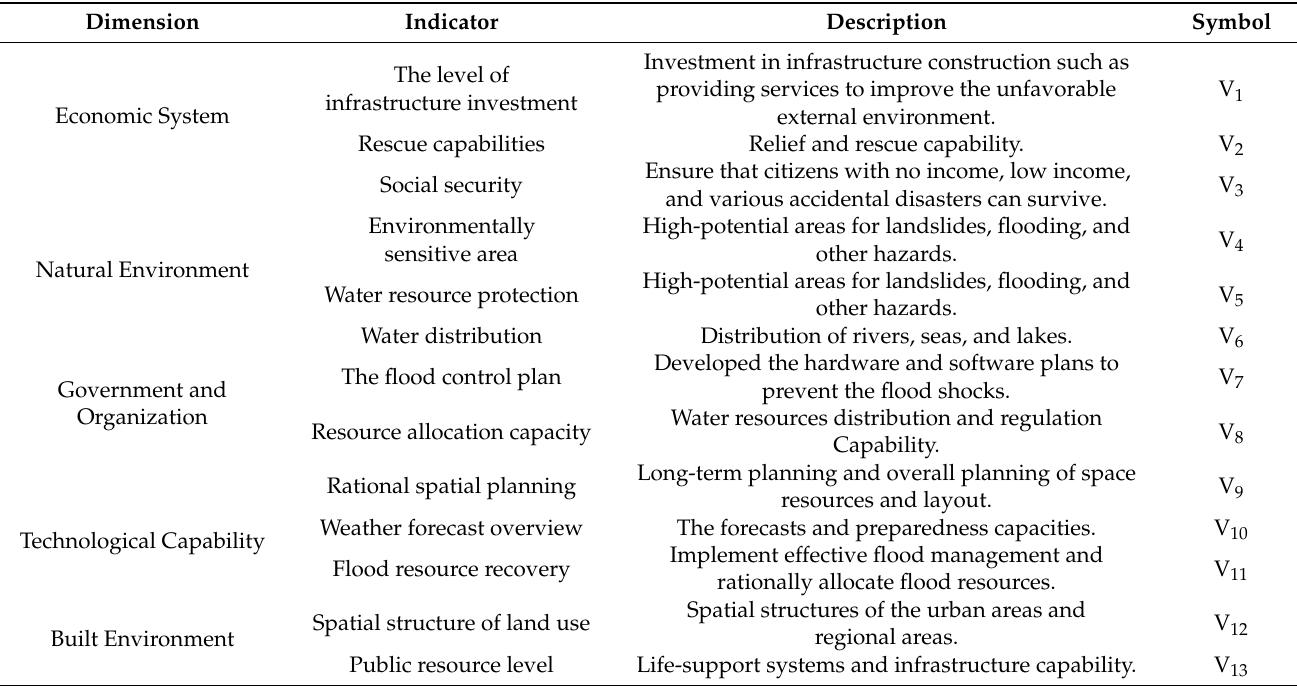
Table 3. Urban flood resilience evaluation index